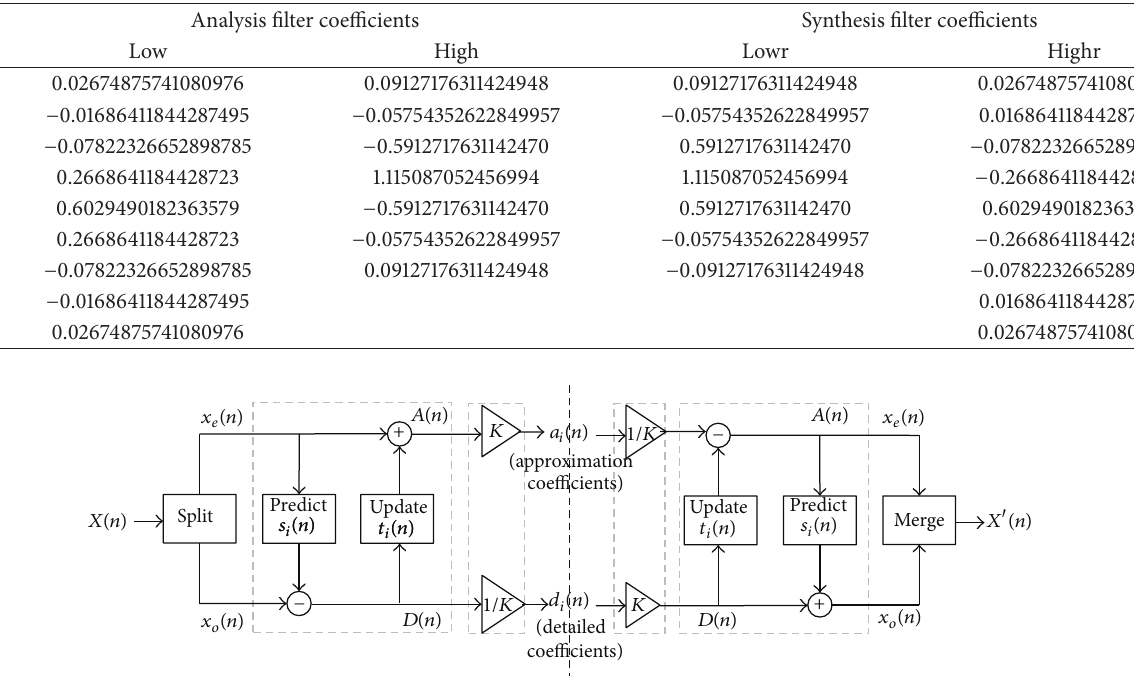
Table 1: CDF 9/7 filter coefficients.